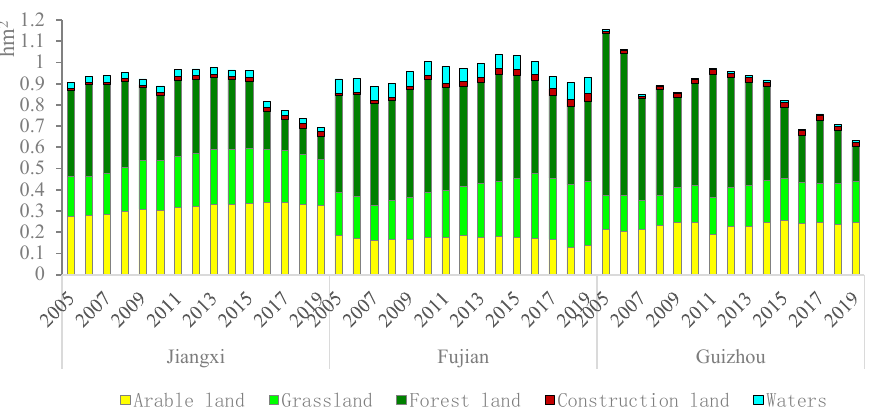
Figure 2. Per capita ecological footprint in the National Pilot Zones for Ecological Conservation.